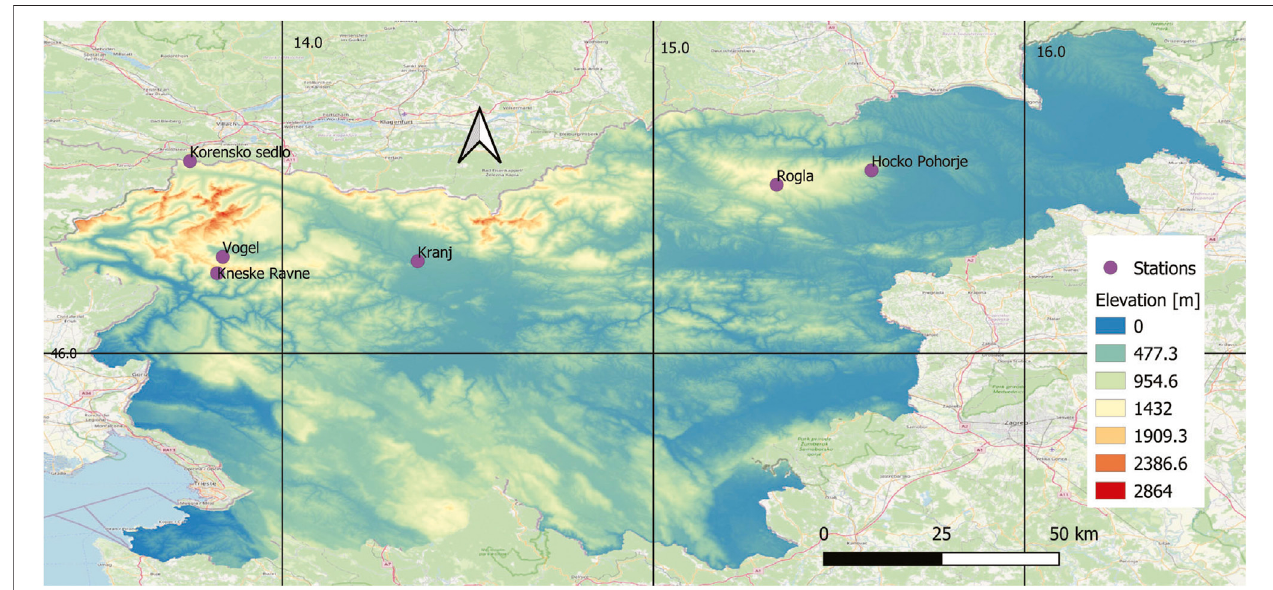
FIGURE 1 | Location of six selected meteorological stations on the topography map of Slovenia (red: higher elevation; green: lower elevation, 0 – 2,864 m a.s.l.).